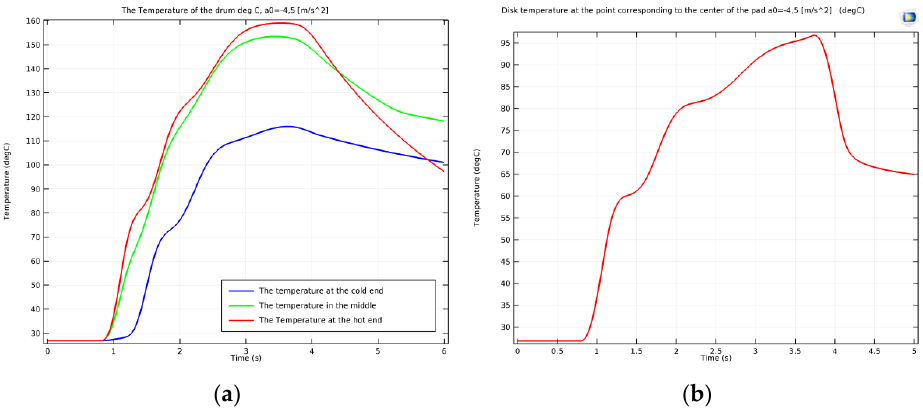
Figure 18. Variation in time of the surface temperature of the ( a ) drum and ( b ) disc during emer- gency braking.